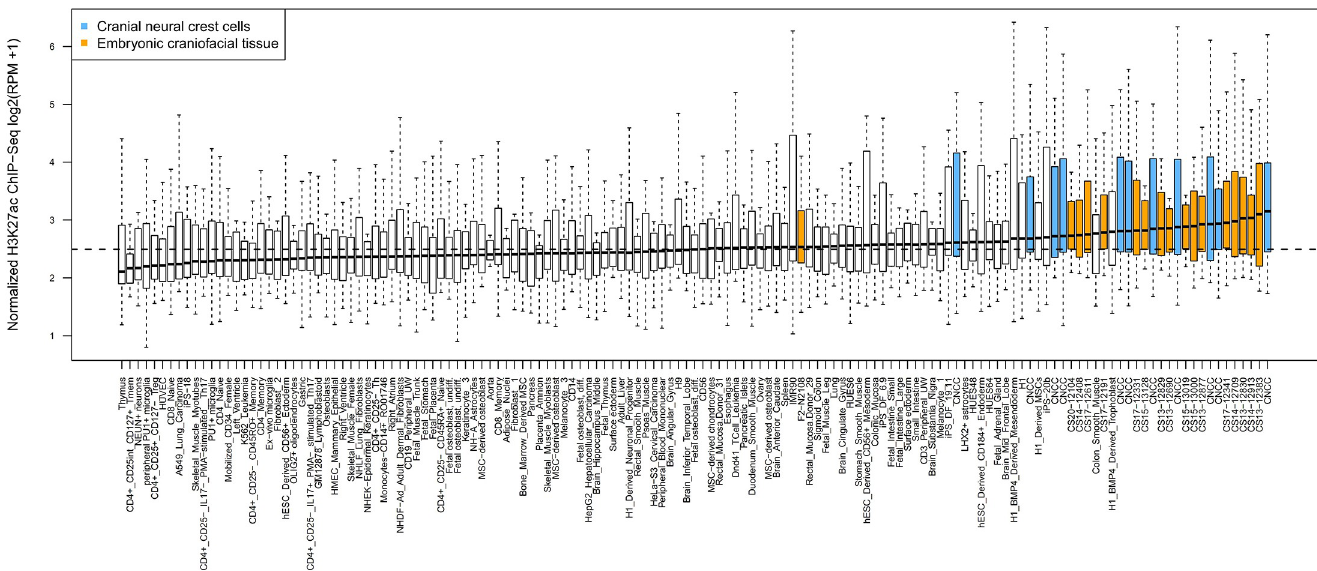
Fig 3. The 20 GWAS loci are enriched for enhancers preferentially active in cranial neural crest cells and embryonic craniofacial tissue. Boxplots indicate H3K27ac signal (log-transformed coverage) in the vicinity of the 20 GWAS loci (within 20kb) in individual samples; cranial neural crest cells and embryonic craniofacial samples are colored blue and orange, respectively. The dashed line at ~2.5 is the median signal across all cell types and